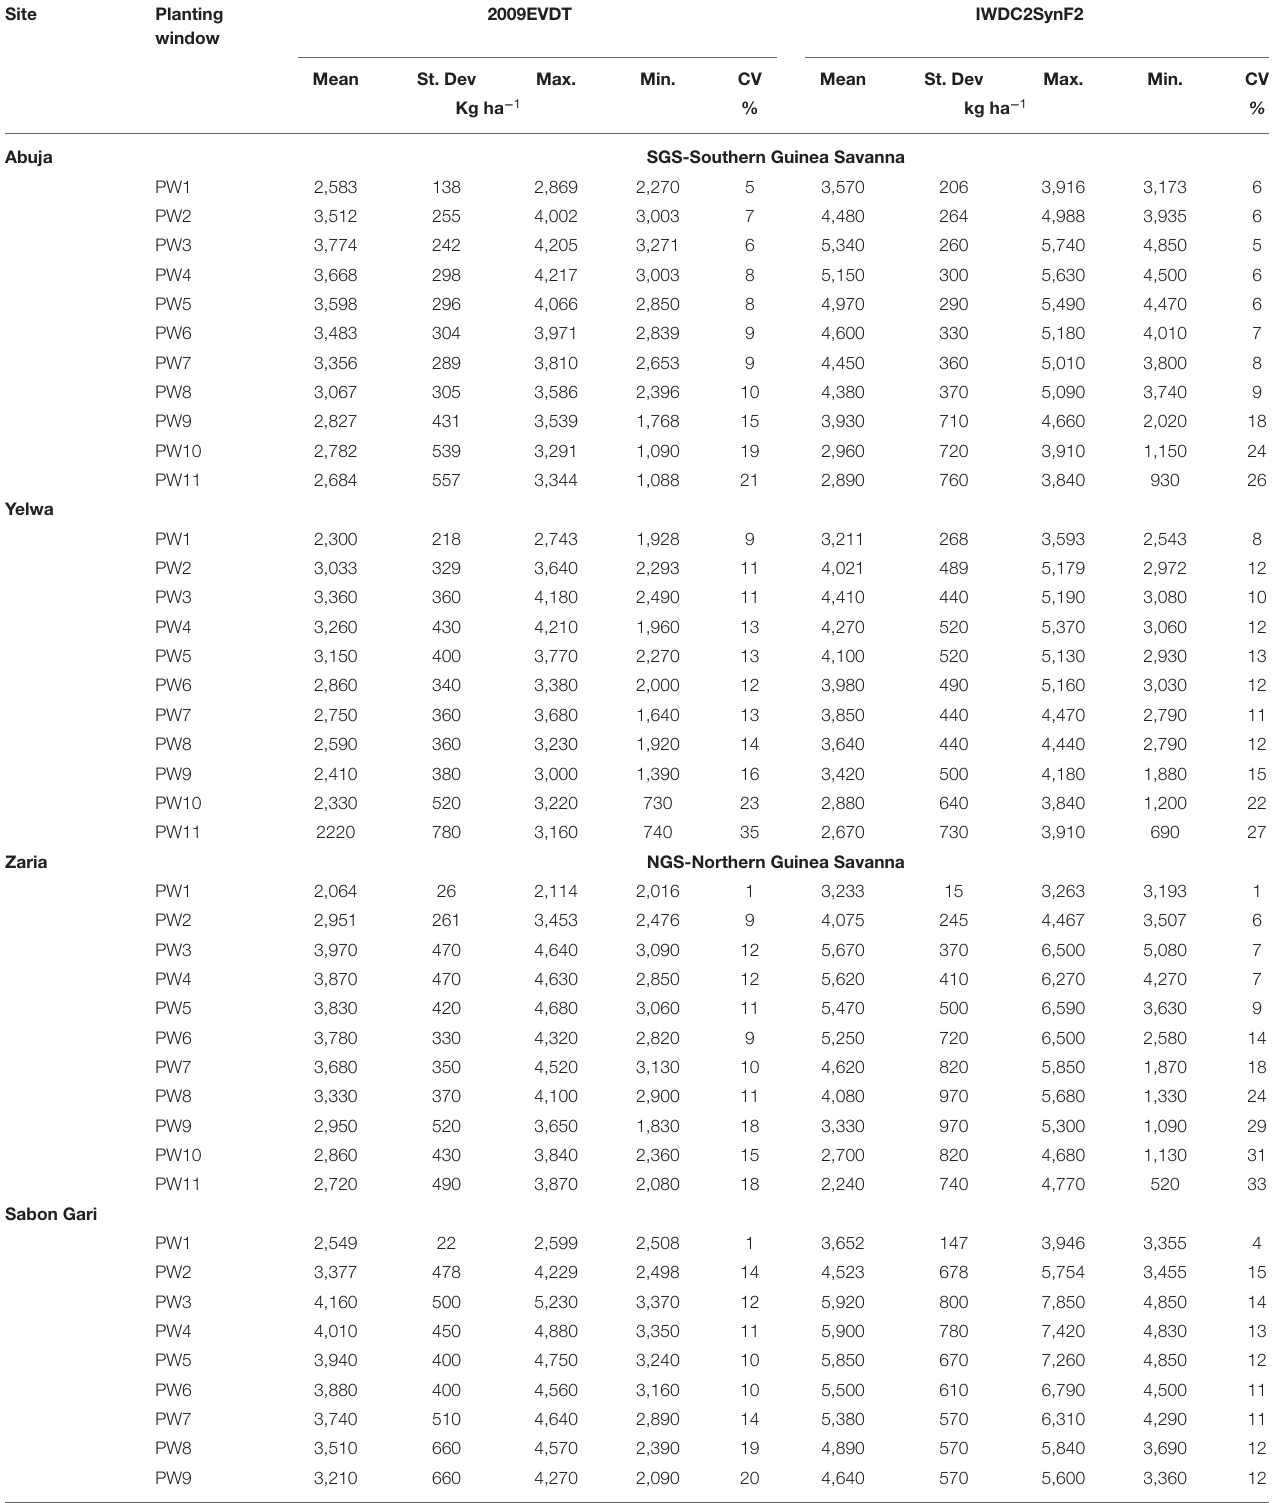
TABLE 4 | Simulated maize grain yield (1985–2015) for different planting windows (PW) in the Southern Guinea savanna (SGS), Northern Guinea Savanna (NGS), and Sudan Savanna (SS) zones respectively Nigeria. Site Planting